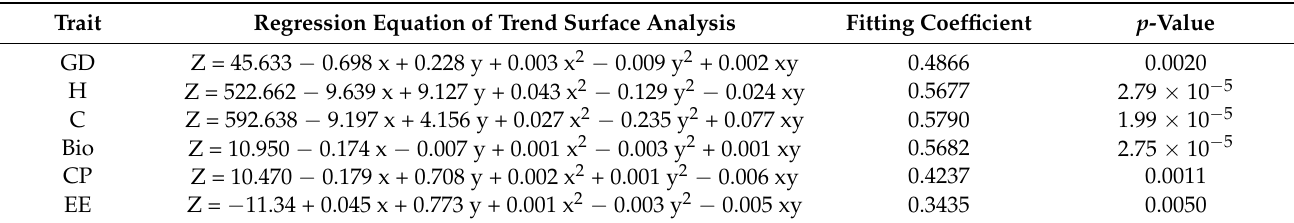
Table 6. Regression equation for each trait.